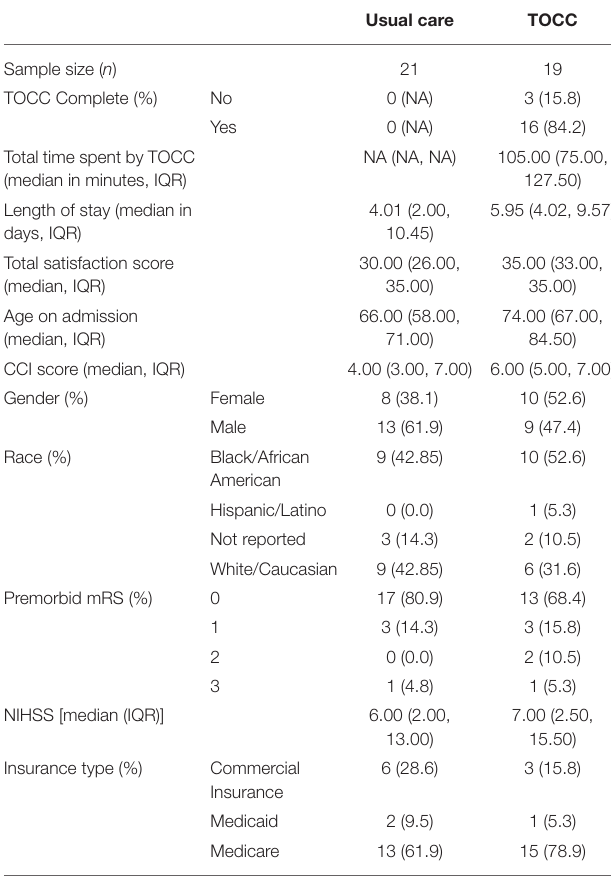
TABLE 2 | Baseline characteristics and descriptive